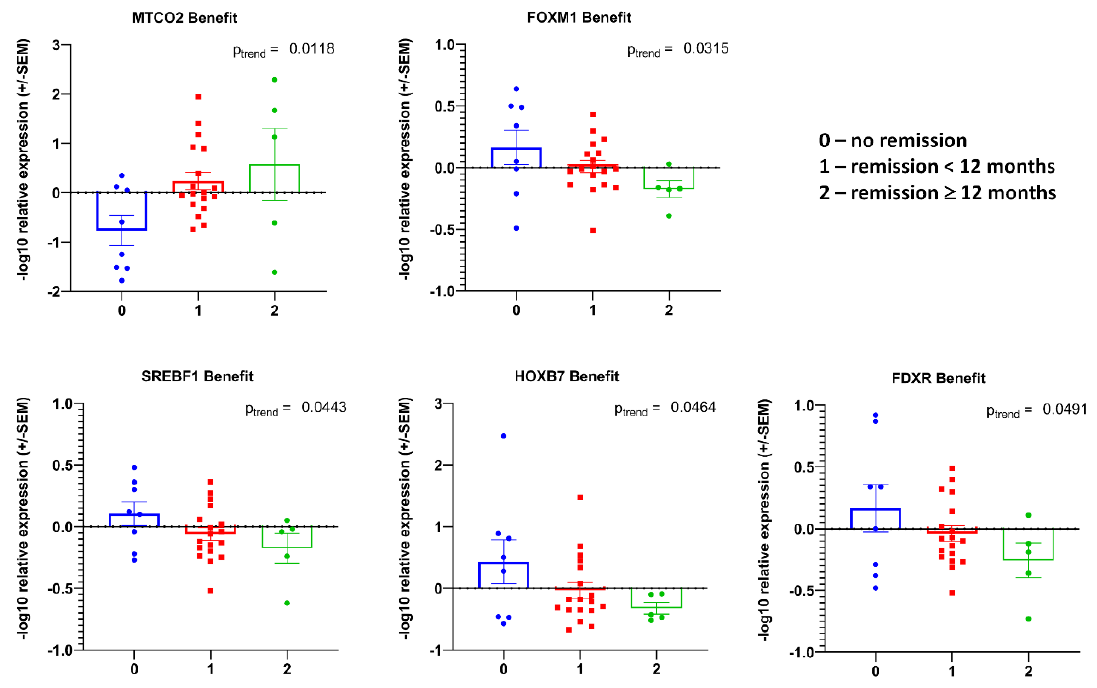
Figure 5. Trends in transcripts ’ levels of expression from blood-derived mRNA and association with treatment response. Log10 relative expression levels of gene transcripts were tested for association with benefit. p values are indicated after linear test for trend following ANOVA. Only significant results in overall cohort are presented. The meaning of the number-coding is as indicated in the figure key. Although no significant difference was found regarding a RT Benefit in the ADT+ and ADT− patients (Mantel – Haenszel chi square 2-tailed p -value 0.26 or 0.99 for no benefit versus short remission or long-term over 12 month remission, respectively), we excluded patients with ADT from the analysis, since the success of salvage RT could not be clearly assessed for them. In this analysis, MT-RNR1 transcript levels were clearly associated with remission and IRF2 transcript levels with the recurrence of disease (Figure 6A,B, respectively).